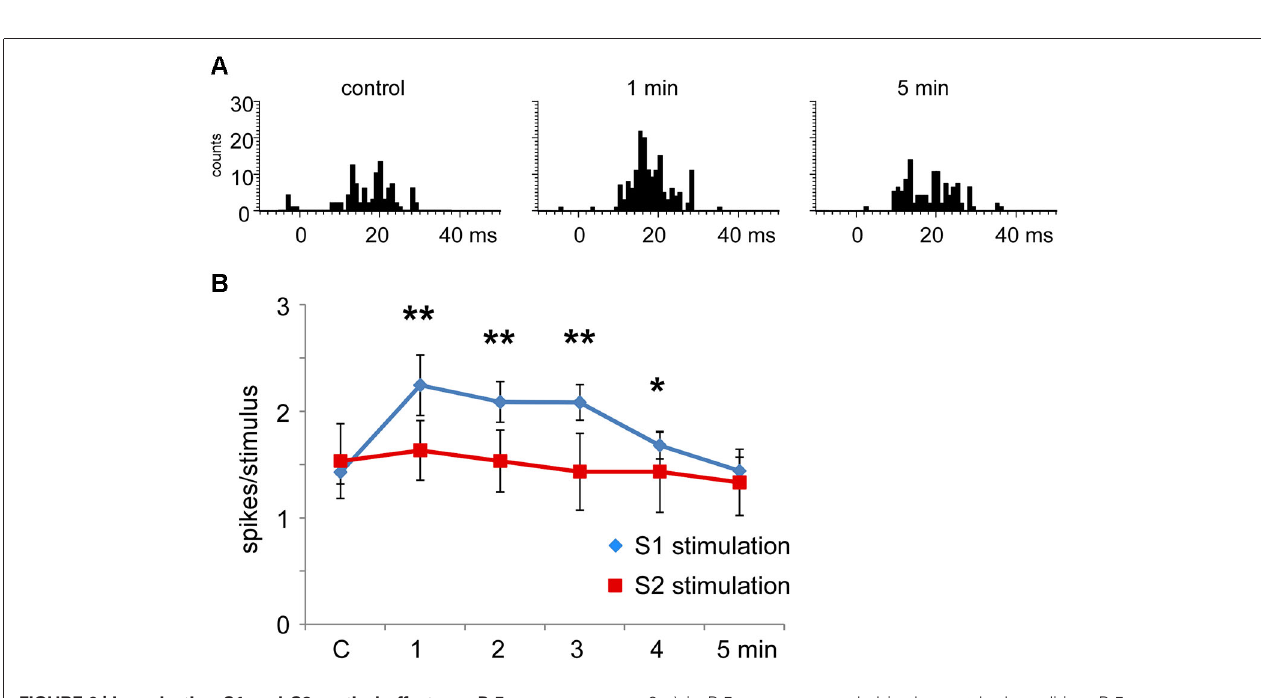
FIGURE 6 | Long-lasting S1 and S2 cortical effects on Pr5 neurons in matching conditions. (A) histograms show PSTHs in control condition, 1 min and 5 min after stimulation train in a representative Pr5 neuron. (B) plot of the mean tactile responses in control condition and after S1 (blue diamonds) or S2 (red squares) cortical electrical stimulation (3 trains of stimuli; 50 Hz during 500 ms repeated each